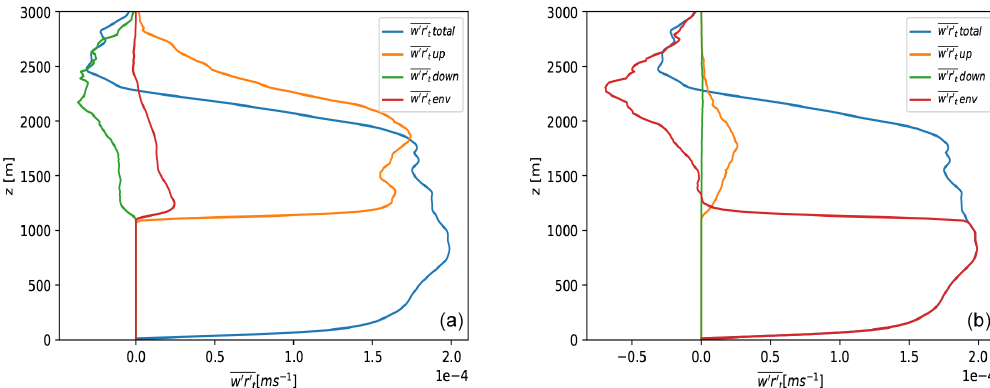
Figure C2. ARM case, ninth simulation hour. Panel (a) shows organised fluxes, distinguishing updrafts (orange), downdrafts (green), and environment (red) as well as the total turbulent transport (blue). Panel (b) shows the small-scale turbulent fluxes using similar colour coding to that in panel (a) .